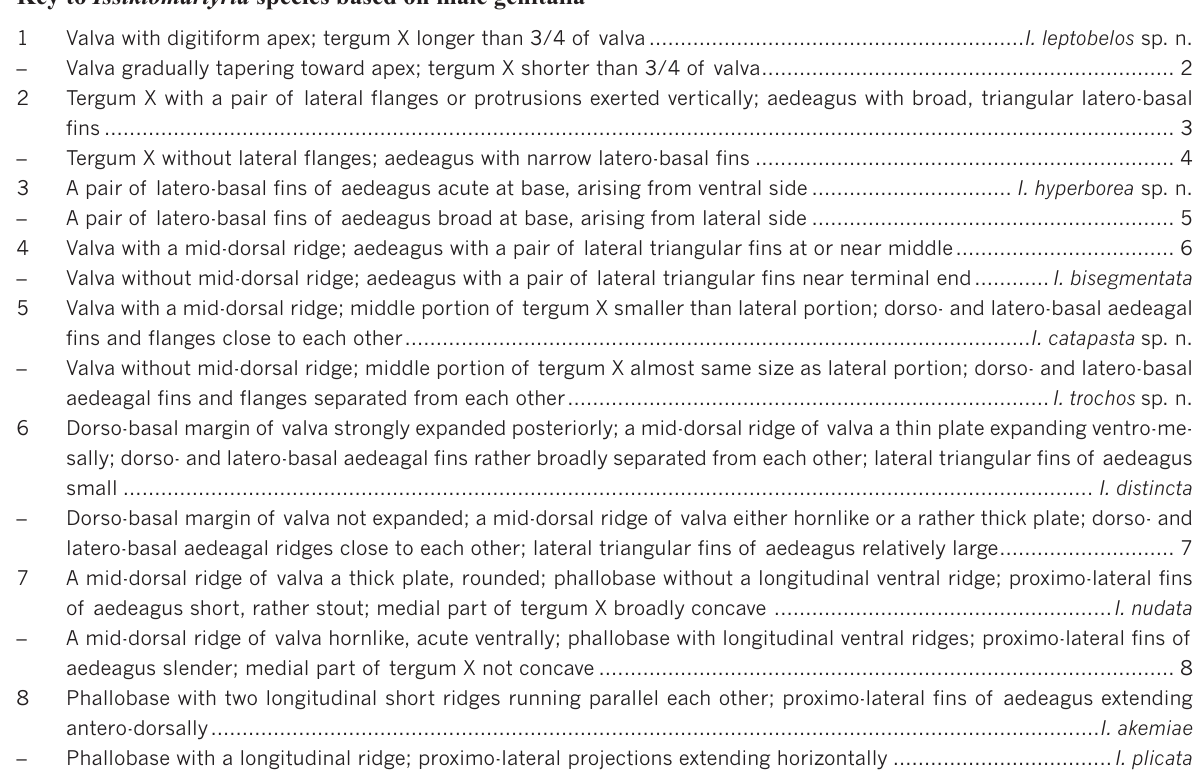
(Fig. 19:19); 2♂ emerged on 29.VI.2014 collected by YI on 17.V.2015 at Hahanaritouge, Koriyama-shi, Fukushima Pref (Fig. 19:20).